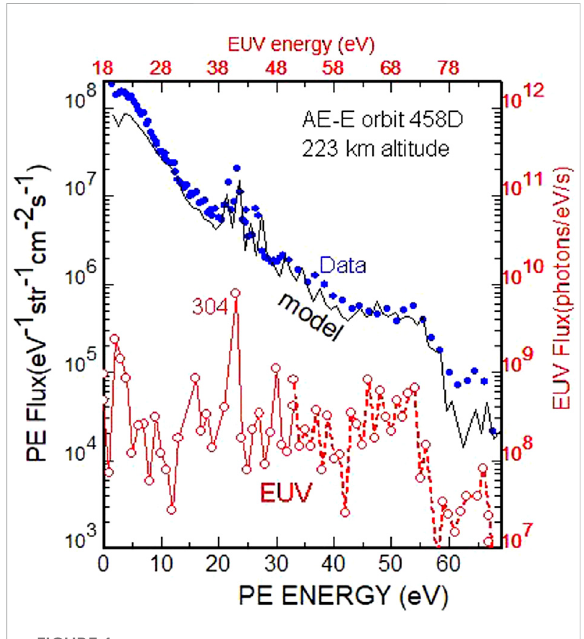
FIGURE 1 Measured(dots)andmodeled(solidblackline)photoelectron fl ux at 223 km. The red solid and dashed lines show the F74113 solar EUV reference irradiance as a function of energy, which has been shifted down by 18 eV (top axis) to approximately line up the EUV photons with the primary photoelectrons that they produce. The dashed line irradiances are double those of the standard F74113